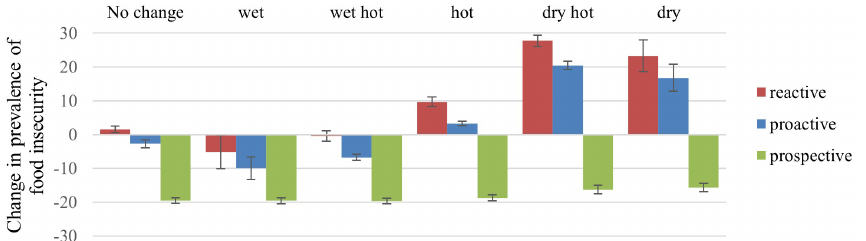
Figure 8. Absolute change (average and standard deviation introduced by sensitivity analysis – variation caused by different model initial- izations and by the different relative importance of the PMT factors for the decisions of households) in the average share of households with food shortages of the last 20 years of the scenario run, compared to the first 20 years of the baseline run before year 0, under different climate and policy intervention scenarios. ADOPT model